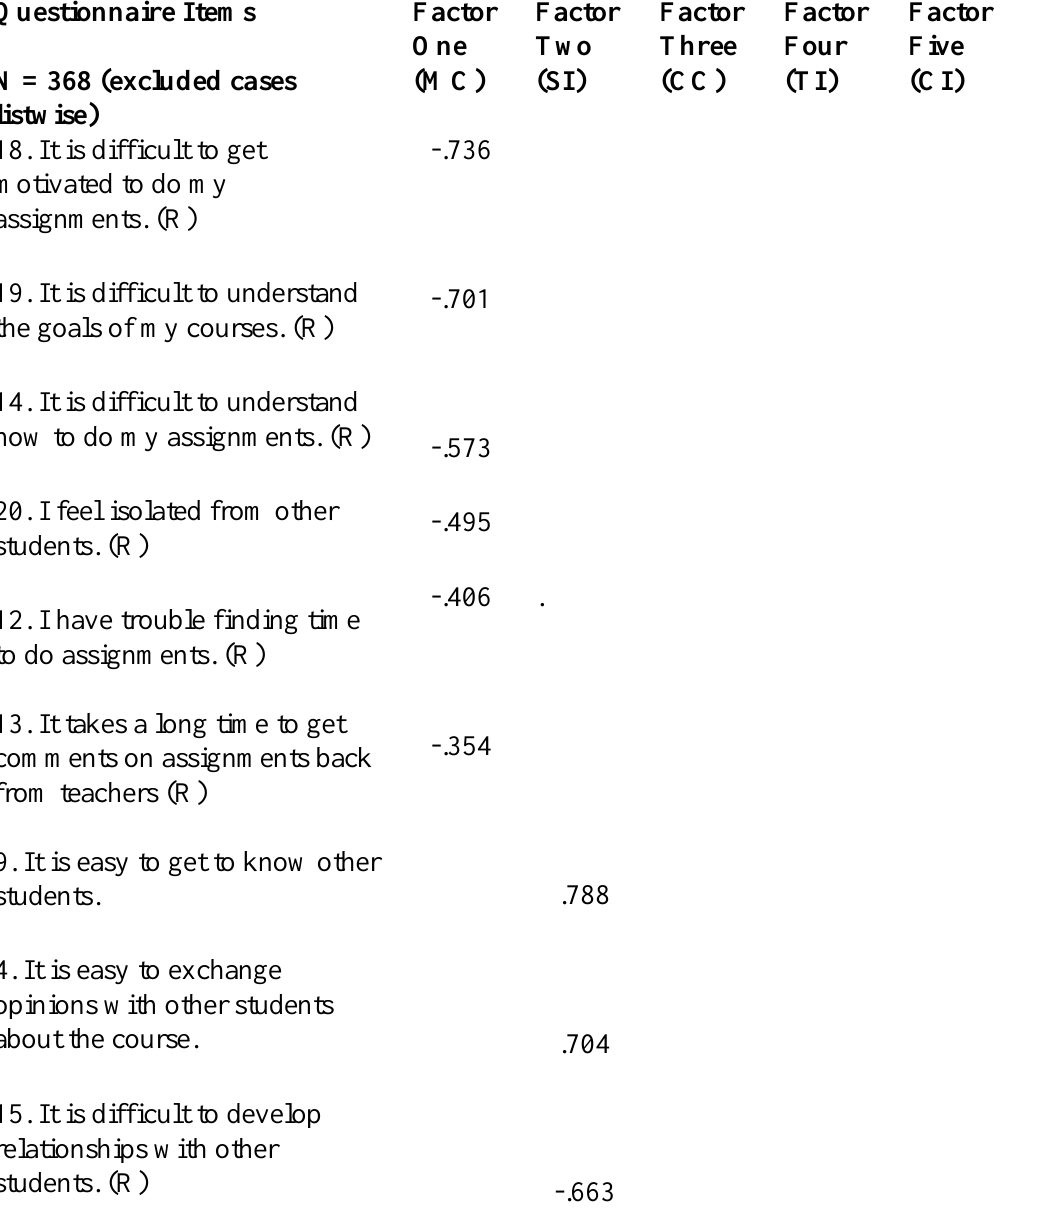
Table A1. Obliquely rotated component loadings of items in Opinions of Distance Learning